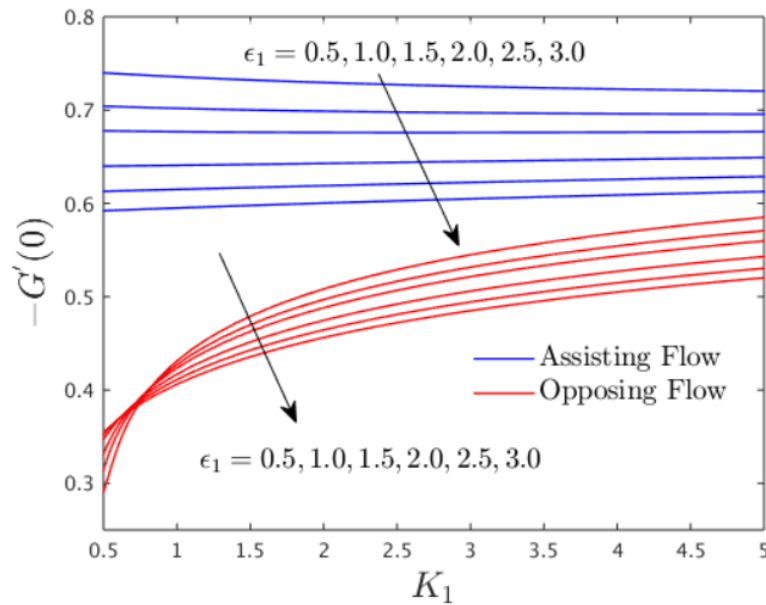
 . Figure 13. Variations of the heat transfer for several values of ε 1 1